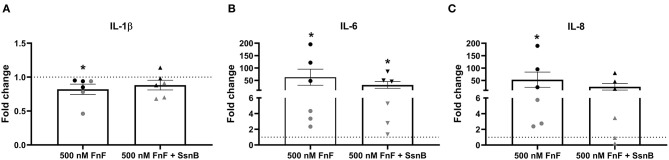
Gene expression of IL-1β (A), IL-6 (B), and IL-8 (C) after 18 h exposure to 30 kDa fibronectin fragments (500 nM) alone and in combination with the TRL-2/TRL-4 inhibitor Sparstolonin B. Values were normalized to the reference gene (GAPDH) and are shown as fold change compared to untreated control (for 500 nM FnF) or Sparstolonin B alone (for 500 nm FnF + SsnB). *Denotes statistically significant differences with p < 0.05. Black symbols indicate high responders (n = 3) and gray symbols indicate low responders (n = 3) (n = 6 total). Points demonstrate NP cells treated with 500 nM 30 kDa FnF. Triangles demonstrate NP cells treated with a combination of FnF and Sparstolonin B.